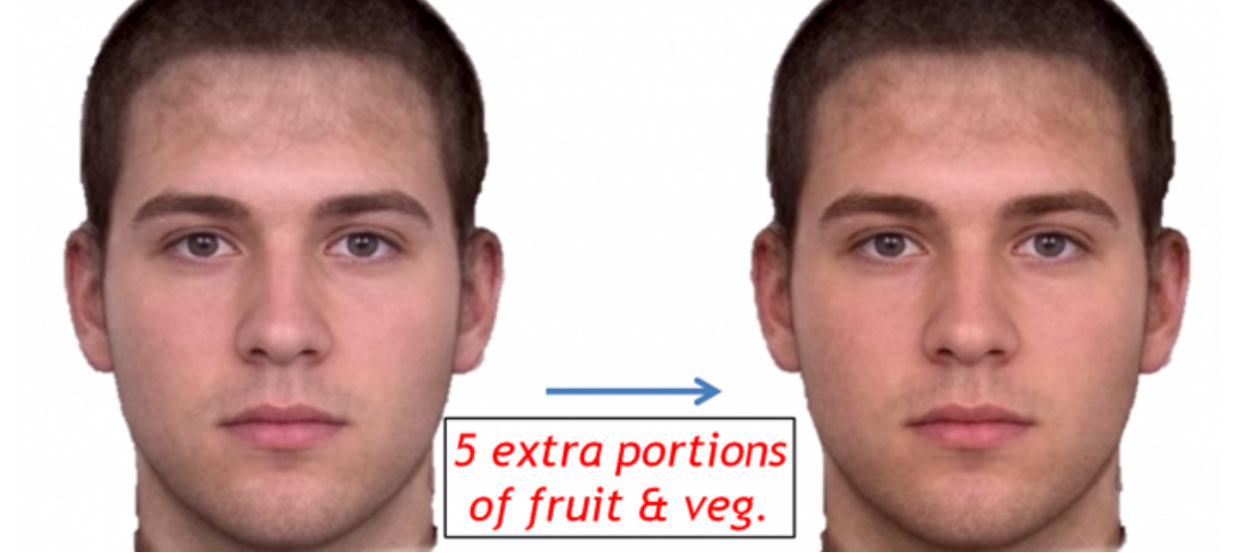
Figure 1. The image shown to participants before answering questions about the skin color benefits of fruit and vegetable